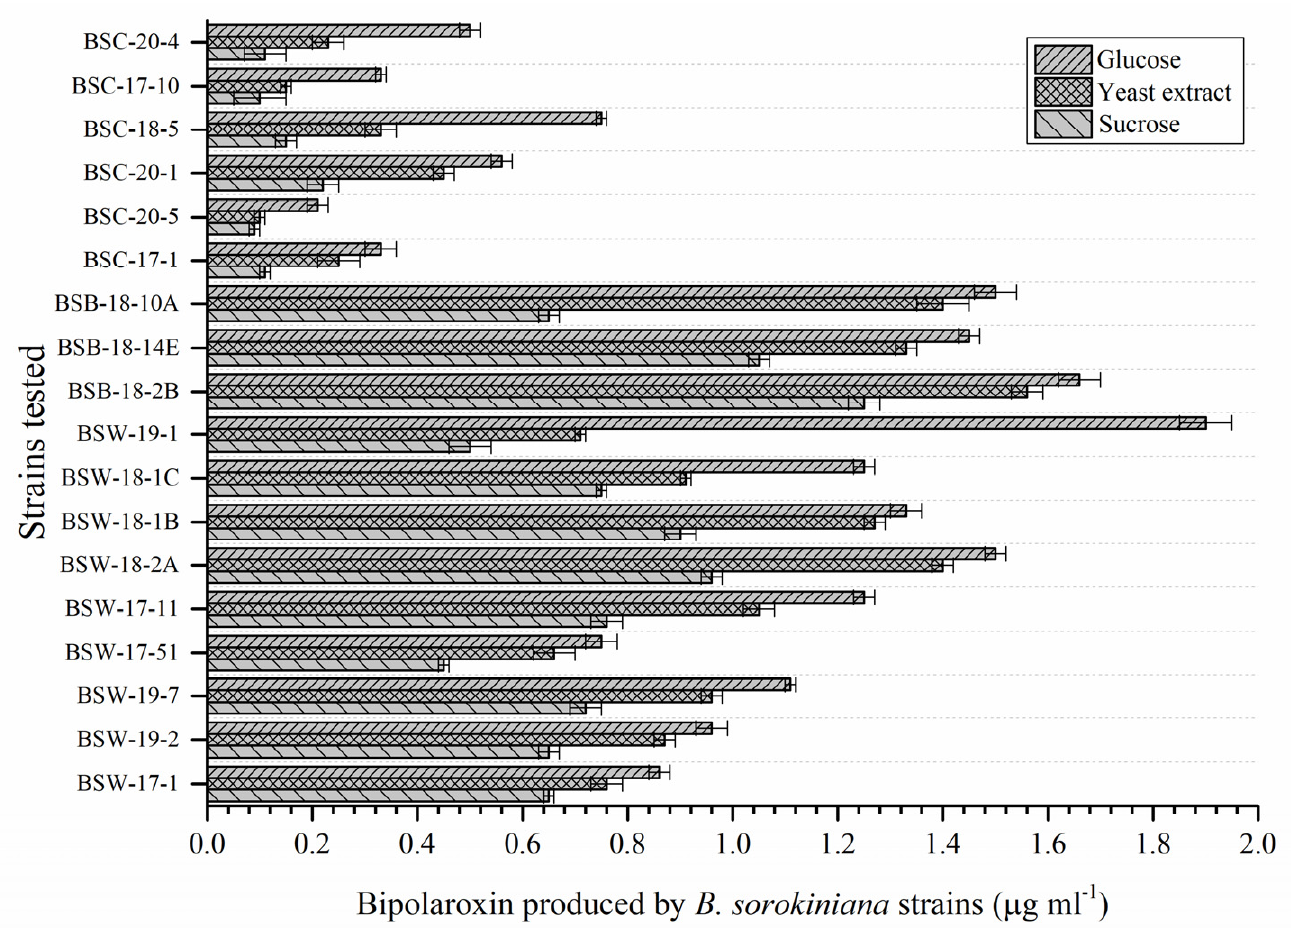
Figure 9. Production of Bipolaroxin by different strains of B. sorokiniana on the minimal media supplemented with sucrose, yeast extract, and glucose under in vitro laboratory conditions. Data are mean ( n = 5) and vertical lines represent the standard deviation (Mean ± SD).